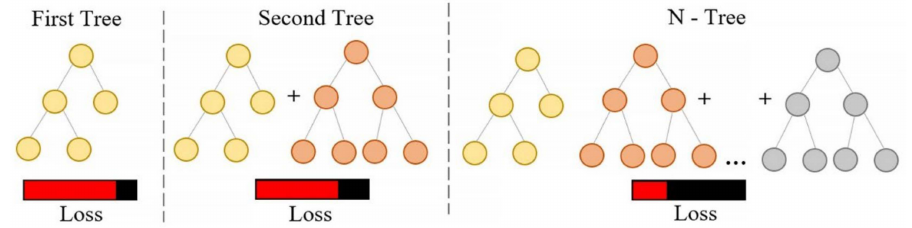
Figure 1. Iterative training of decision trees in gradient boosting.